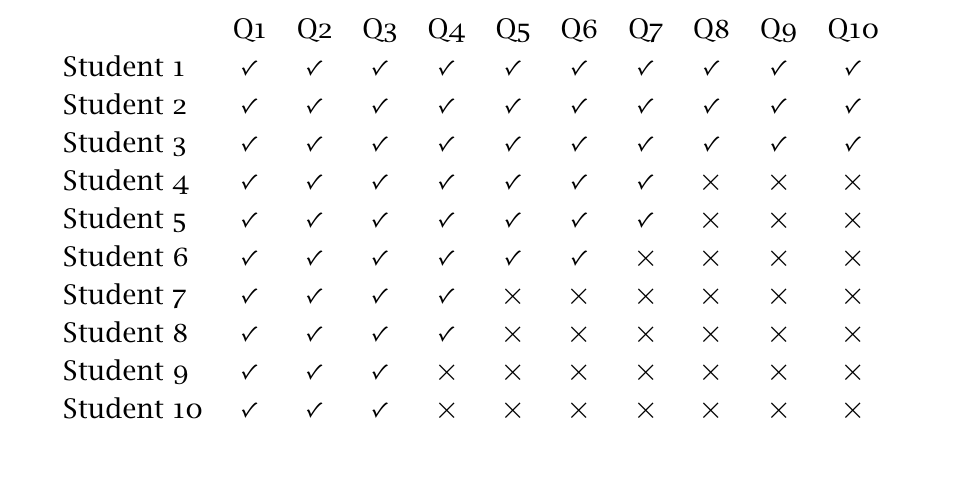
Figure 1 Example of two-dimensional data